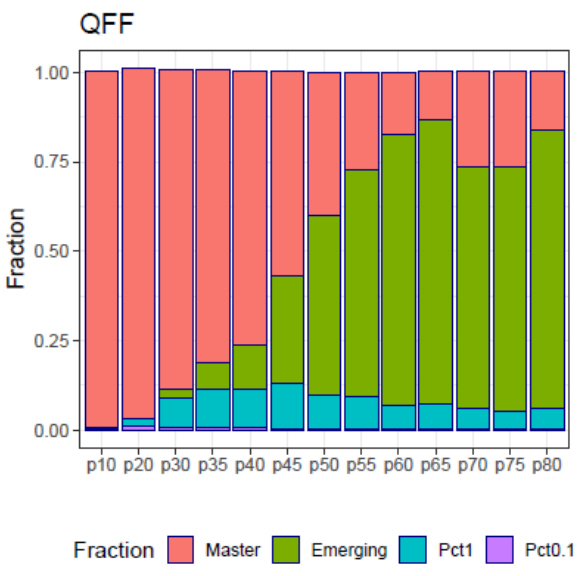
Figure 7. Haplotype distributions in the simulated follow-up example. The dominant haplotype at each step is labeled with a + sign.